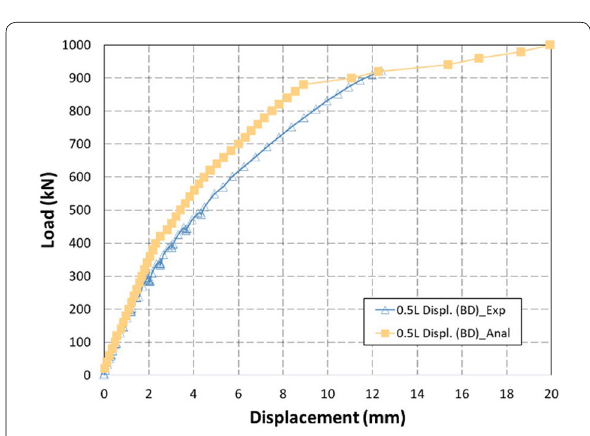
Fig. 22 BD comparison with FEM